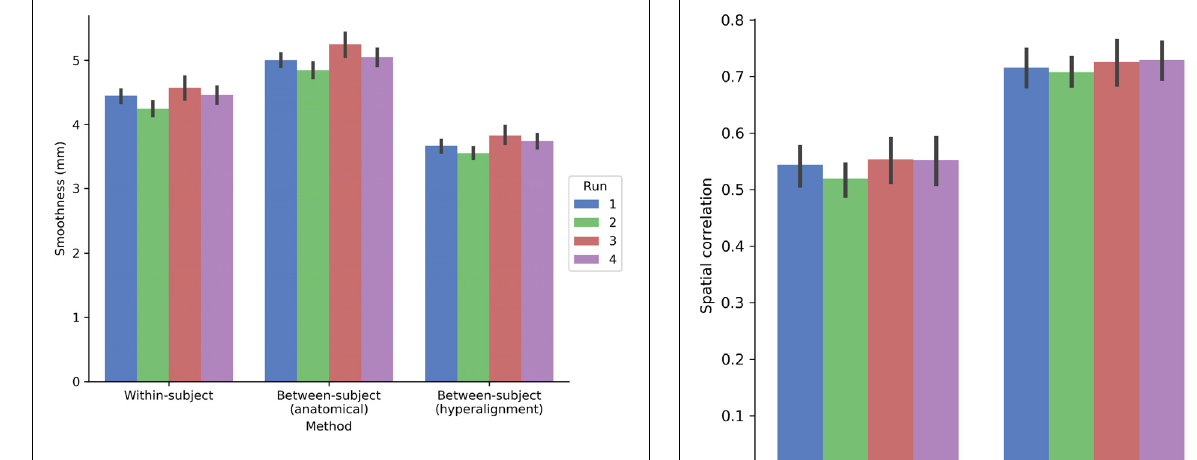
FIGURE 7 | Spatial smoothness (FWHM) of model prediction performance maps on the cortical surface. The between-subject model performance maps using anatomical alignment are blurred relative to the within-subject model performance maps, while the hyperaligned between-subject model recovers the spatial specificity of the within-subject model. The height of each bar indicates spatial smoothness averaged across hemispheres and participants for each run. Error bars indicate bootstrapped 95% confidence intervals estimated by resampling participants (1,000 bootstrap samples).